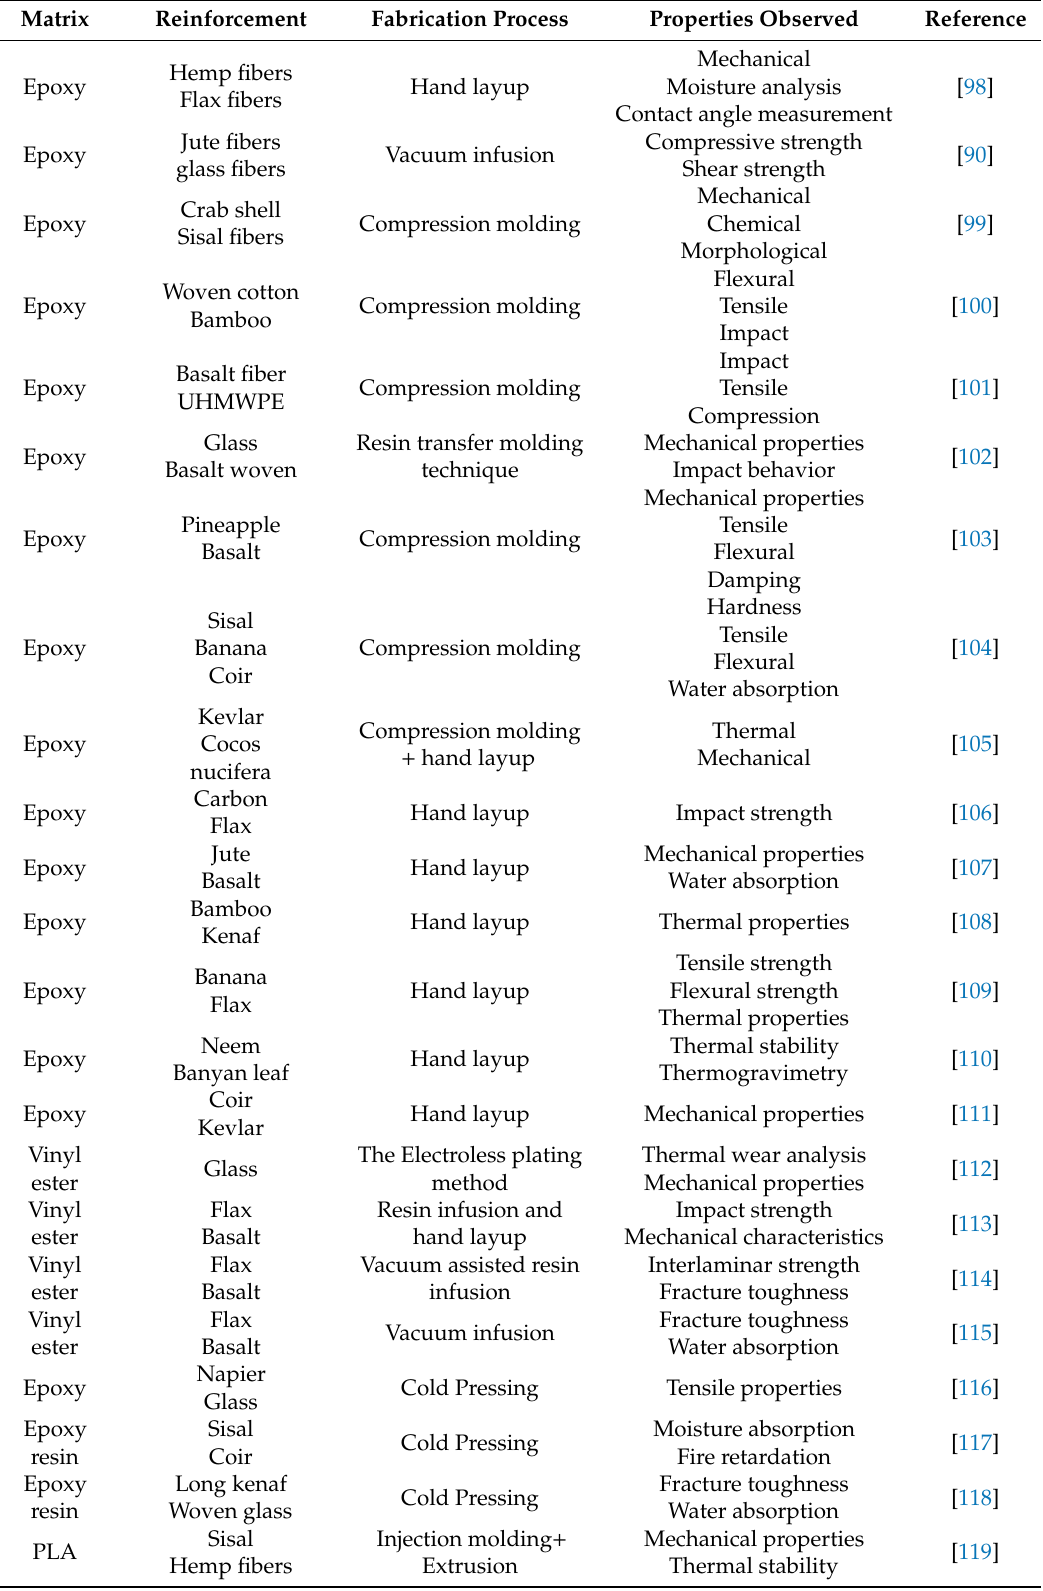
Table 12. Recent research on thermoplastic hybrid composites and fabrication